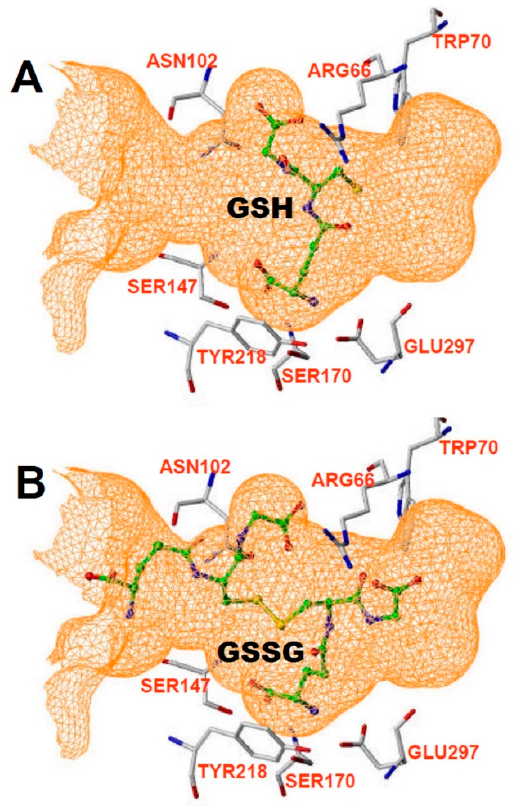
Figure 3. Binding pocket from Wang et al. [1], showing that it can accommodate either ( A ) GSH or ( B ) GSSG. or ( B )